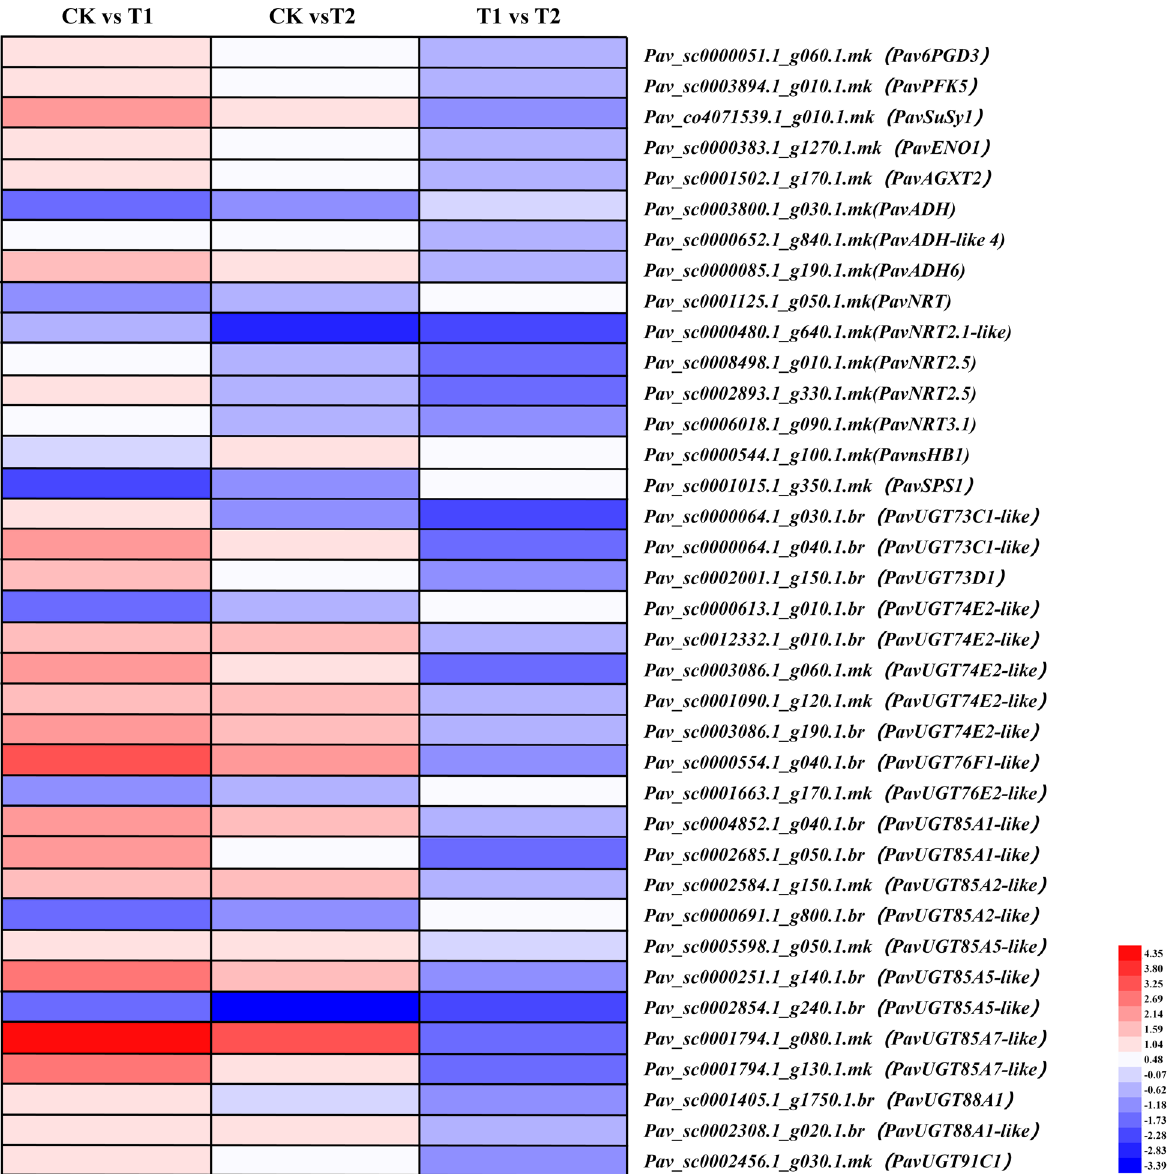
Fig. 6 Expression profiles of differentially expressed genes related to energy production, shown using a heatmap. The scale of color intensity is in the lower right quarter of heatmap, representing the log 2 fold-change values. Fold-change refers to the ratio of gene expression level in cherry rootstock leaves between control (CK) and treatments